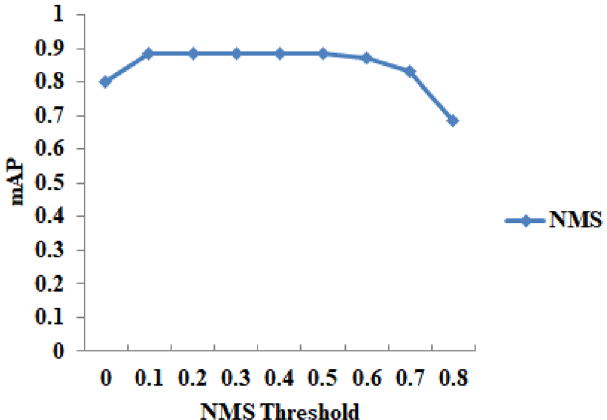
Figure 11. The mAP under different NMS thresholds on the dataset A.